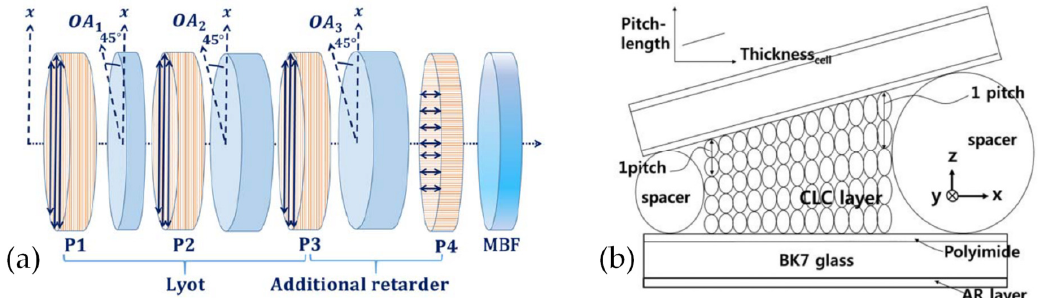
Figure 10. Schematic diagram of ( a ) LC filter based on a Lyot filter [69] and ( b ) the wedge CLC cell with a pitch gradient [70]. Reprinted with permission from Refs. [69,70]. 2016 The Optical Society and 2019 IEEE.